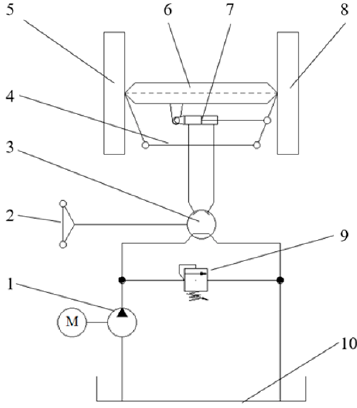
Figure 4. Schematic diagram of the steering system. 1 represents the hydraulic pump, 2 represents the electric steering wheel, 3 represents the full hydraulic steering gear, 4 represents the steering tie rod, 5 represents the left steering wheel, 6 represents the steering front axle, 7 represents the steering hydraulic cylinder, 8 represents the right steering wheel, 9 represents the unloading valve, and 10 represents the oil tank.